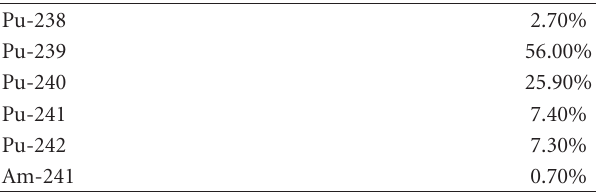
Table 3: Isotopic vector of the plutonium, corresponding to the average plutonium expected to be available in France from 2016 [8].